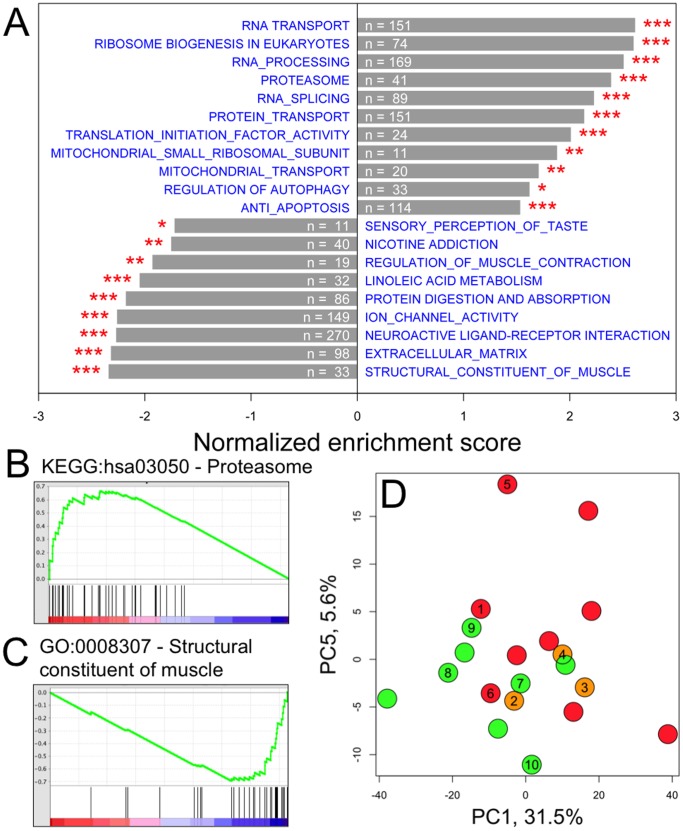
Differential gene expression in RC disease muscle.(A) Significantly differentially expressed gene sets identified by GSEA (See File S2 for complete results). Positive and negative enrichment scores, respectively, indicate up- and down-regulation in RC disease. Numbers indicate counts of genes in each gene set that were measured by our experiment. * p<0.05; ** p<0.01; *** p<0.001. (B–C) Running enrichment scores of two significantly differentially expressed gene sets identified by GSEA. In each plot, the green and black lines, respectively, convey the running enrichment score and the genes categorized into the gene set as defined by KEGG pathway or GO gene ontology. The colored panel at the bottom indicates the level of differential expression from the most up-regulated (red) to most down-regulated (blue) in RC disease. (B) Proteasome pathway genes were generally up-regulated in RC disease muscle. (C) Structural muscle proteins were generally down-regulated in RC disease. (D) Unsupervised clustering via principal component analysis (PCA) identified distinctive transcriptome groupings among muscle from subjects categorized as color-detailed and defined in Fig. 1 based on having “definite” RC disease (red), “suspected” RC disease with abnormal muscle RC biochemistry (dark pink), “suspected” RC disease with either no biopsy performed or no definitive biochemical abnormalities identified (light pink), pyruvate metabolism defect controls (light gray), ‘other disease” controls (dark gray), and healthy controls (brown). Numbered circles indicate subjects also studied in the fibroblast data set (Fig. 3D).